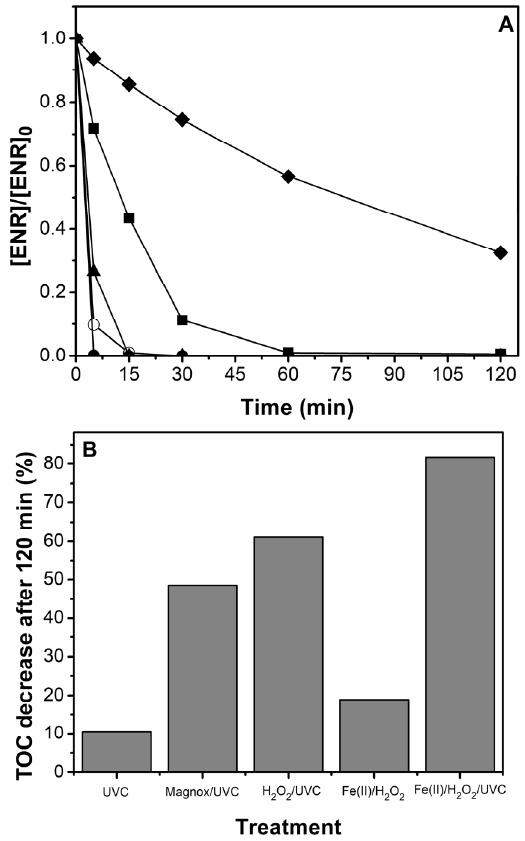
Figure 5. Enrofloxacin (ENR) 25 mg/L removals at pH 2.8 with air flow of 30 L/min. ( A ): UVC ( ◆ ), Magnox/UVC ( ■ ), H 2 O 2 /UVC ( ▲ ), Fenton ( ○ ), and photo ‐ Fenton ( ● ); ( B ) mineralization percentages.